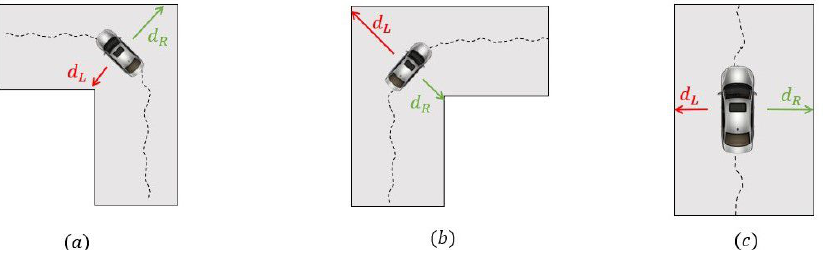
Figure 20. Testing Paths. ( a ) Left turn. ( b ) Right turn. ( c ) Straight. d L ; is the distance from the center of the car to the left wall. d R ; is the distance from the center of the car to the right